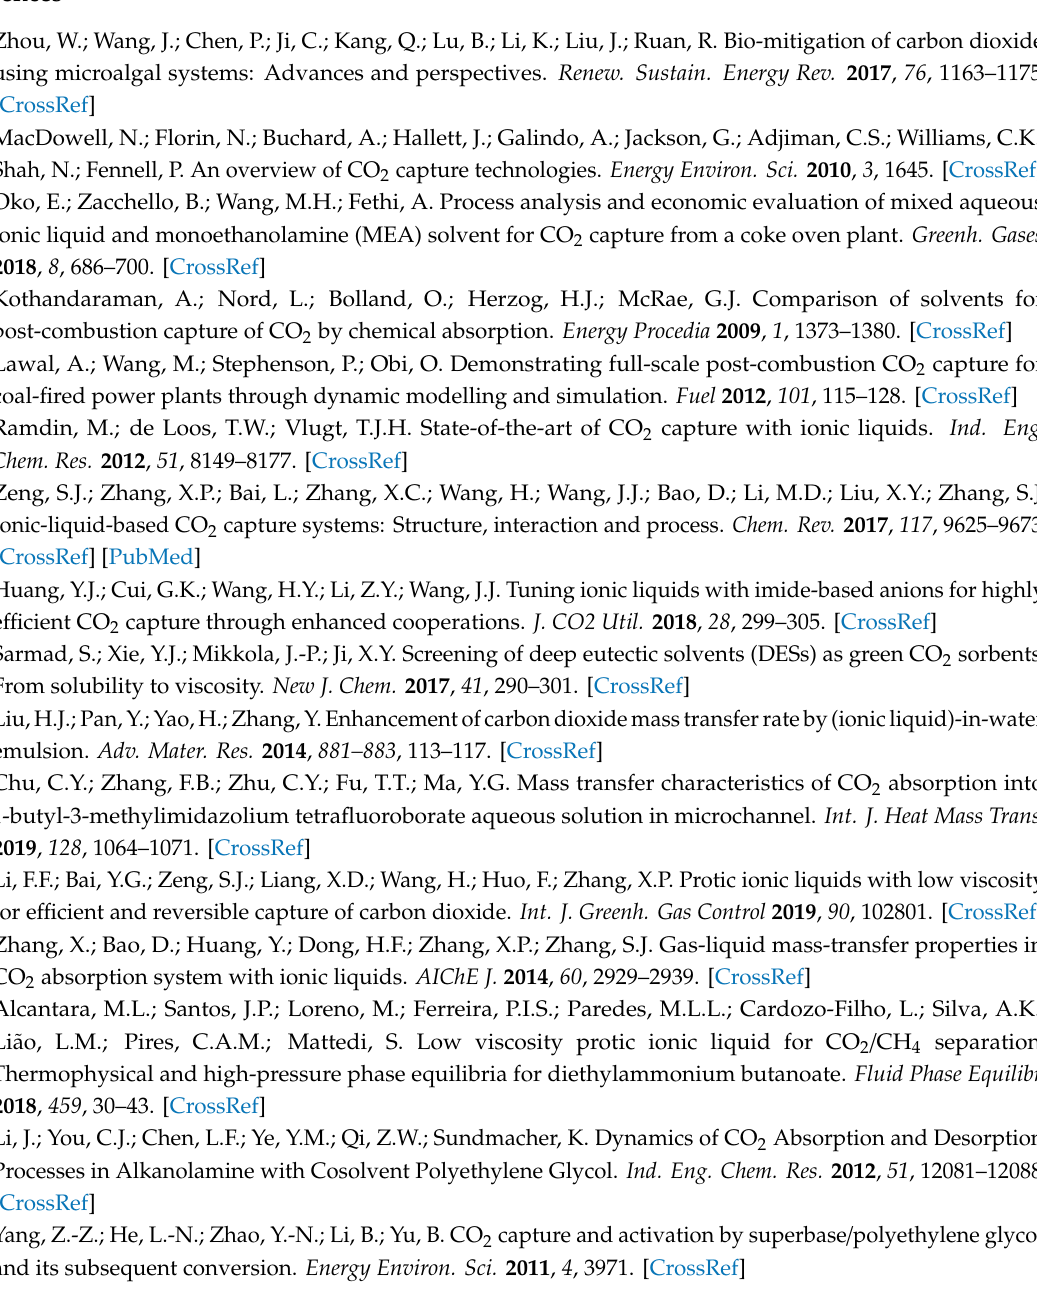
Table S1: Full names and abbreviations of ILs, components of DESs and hybrid